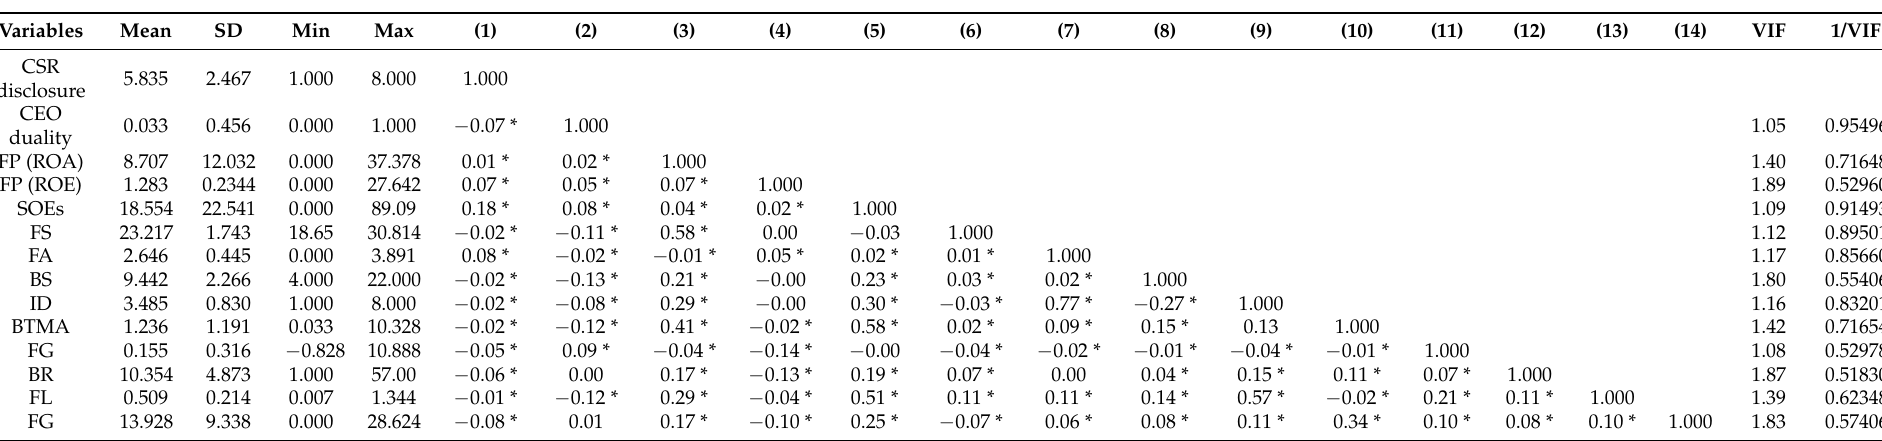
Table 3. Descriptive statistics and correlation